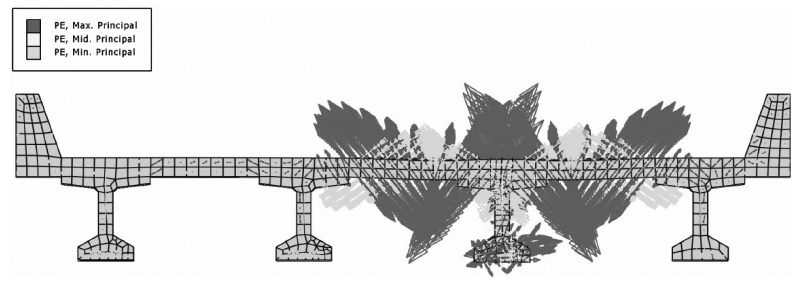
Fig. 26. Principal plastic strain direction, blast above, centered on a